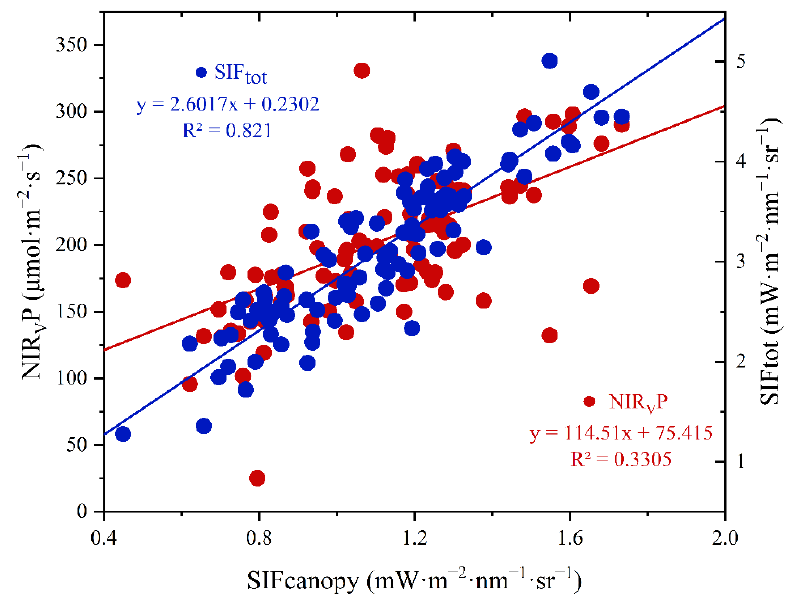
Figure 3. Overview of the relationships between SIF canopy and SIF canopy -related variables in the moderate stage of disease onset ( n = 99).